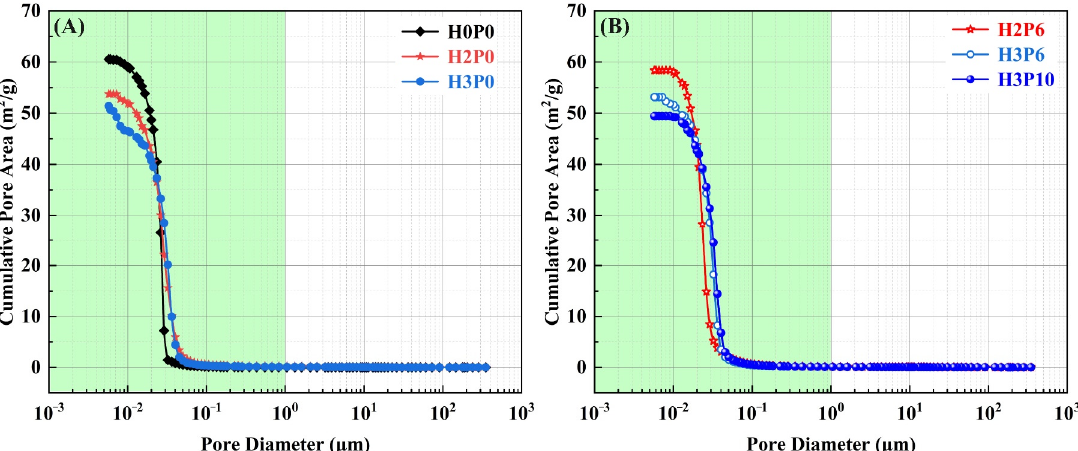
Figure 9. Cumulative pore area of matrix and geopolymer foams: ( A ) H0P0, H2P0, and H3P0; ( B ) H2P6, H3P6, and H3P10.